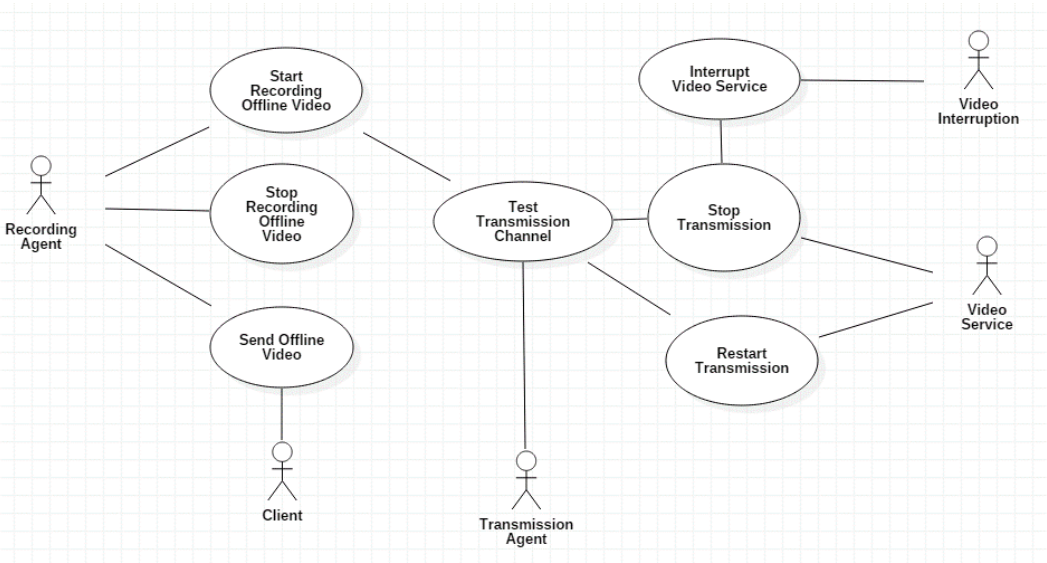
Figure 4. Diagram of actors and use cases of the video surveillance system when an interruption occurs. Table 2. Description of actors and use cases of Figure 4.